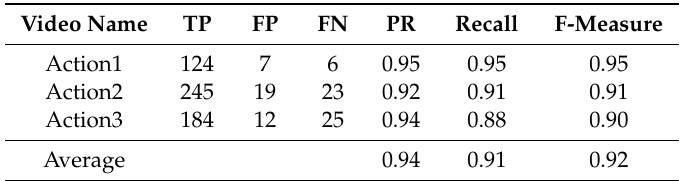
Table 2. Detection results performance.